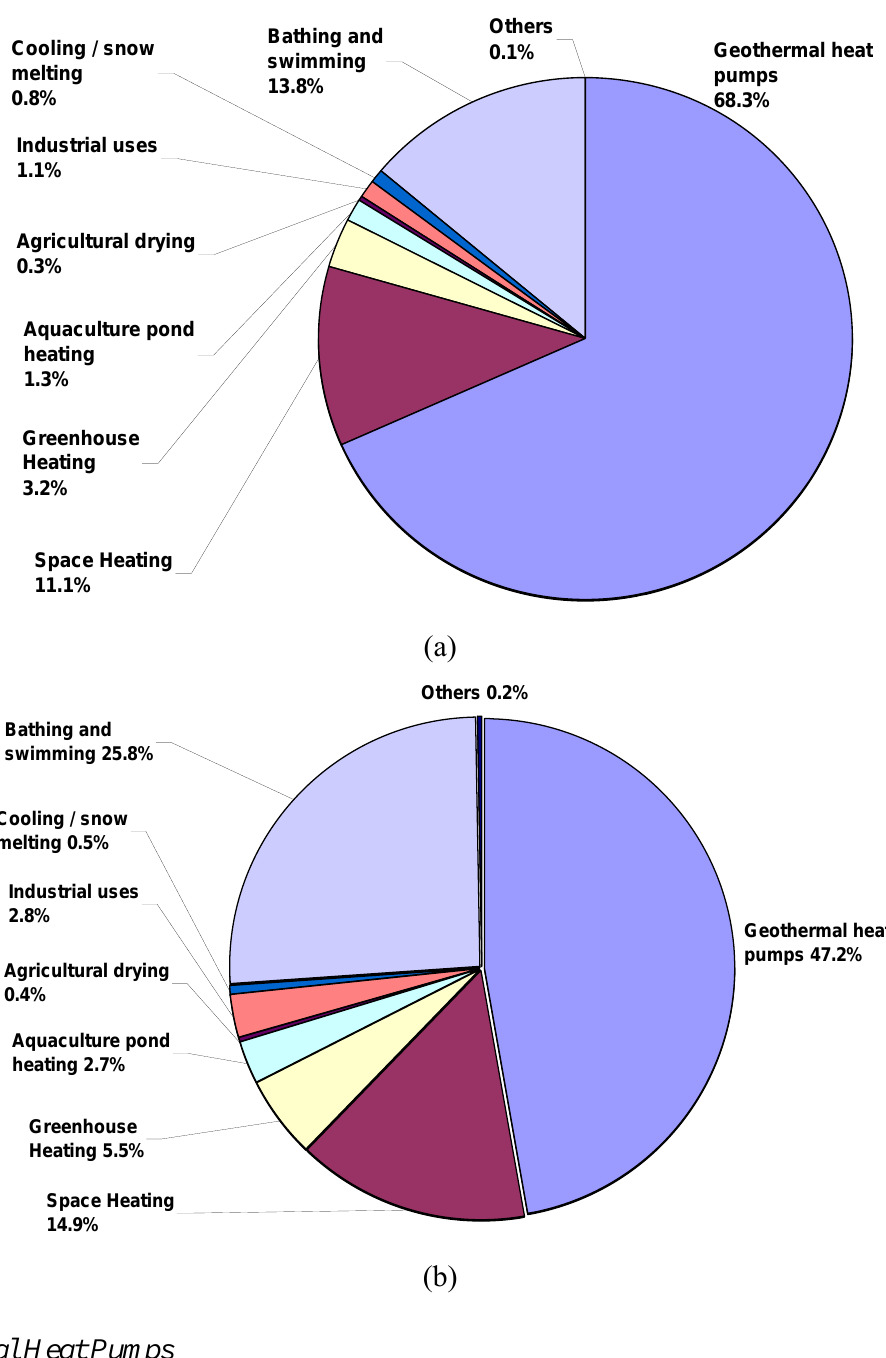
Figure 3. Geothermal direct applications worldwide in 2010, distributed by: (a) percentage of total installed capacity; and (b) percentage of total energy use